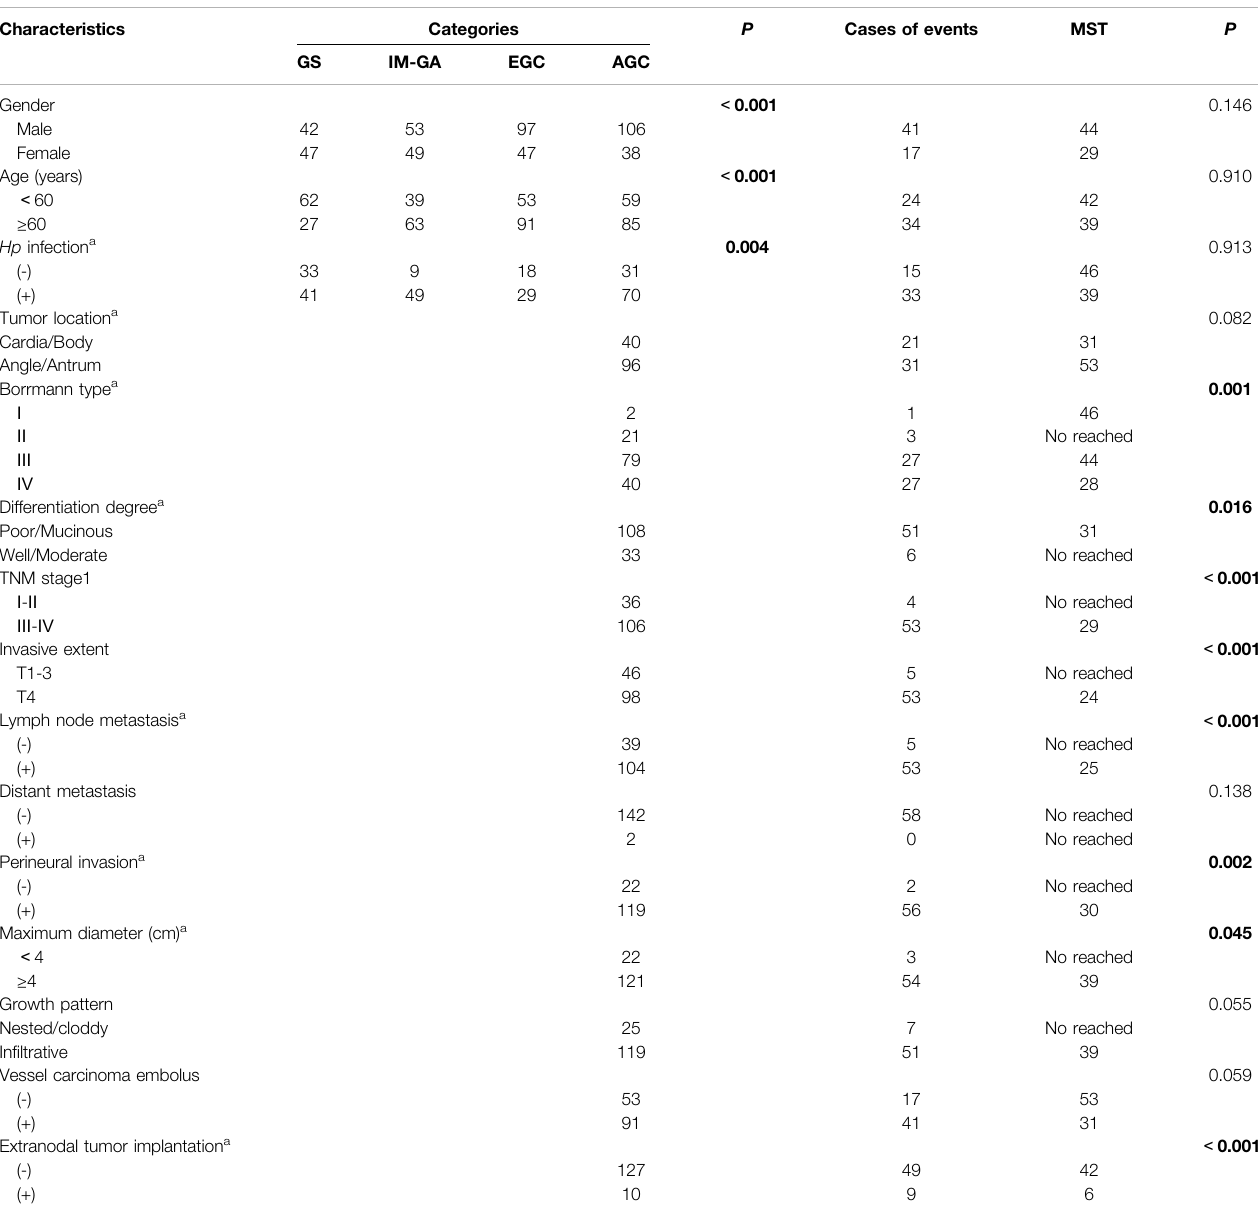
TABLE 1 | Clinicopathological parameters of GS, IM-GA, EGC, AGC, and survival in AGC.